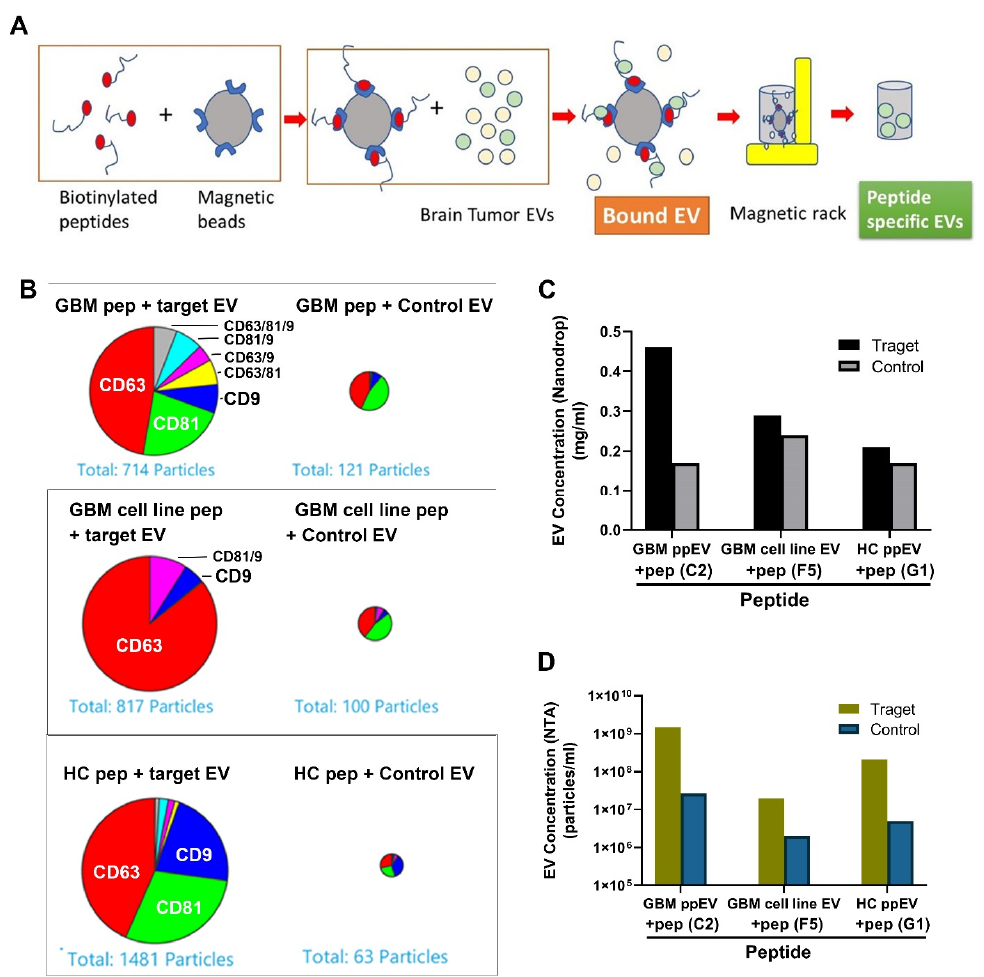
only minimal levels of luminescence in SH-SY5Y cells after treatment with GBM, MMA, HC EVs for 4 h. There were no significant differences in apoptosis in any of the EV-treated cells (Figure 5B, n = 6 for GBM EV, n = 8 for MMA EV, n = 5 for HC EV). This observation indicated that apoptosis was not involved in EV-induced toxicity. To further uncover the mechanism of GBM EV induced cytotoxicity in neurons, we measured necrosis using PI red fluorescence (535/617 nm) in SH-SY5Y cells treated with EVs purified from individual plasma of 14 GBM patients, 14 MMA patients, and 8 healthy controls. We demonstrated that GBM plasma EVs produced significantly higher levels of necrosis compared to MMA EVs ( p = 0.002) and healthy control EVs ( p = 0.008) (Figure 5C). The results suggest that GBM EV can cause necrotic cell death in neurons.